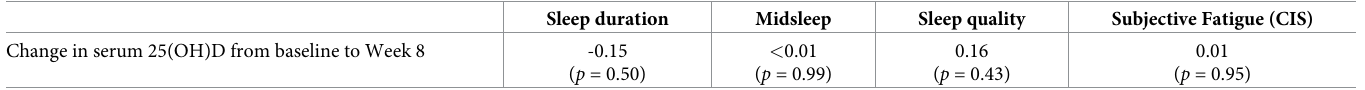
Table 7. Pearson correlations between change scores in serum 25(OH)D and sleep duration, midsleep, sleep quality and subjective fatigue. Sleep duration Midsleep Sleep quality Subjective Fatigue (CIS) Change in serum 25(OH)D from baseline to Week